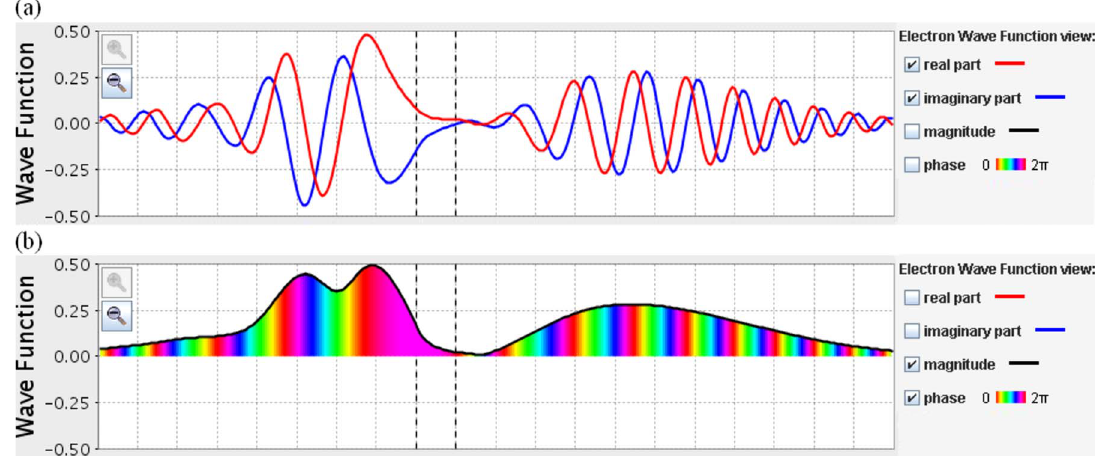
FIG. 13. (cid:1) Color (cid:2) (cid:1) a (cid:2) A representation showing the real and imaginary parts of a wave function and (cid:1) b (cid:2) a representation showing the magnitude and phase of a wave function. In interviews we see that students can make sense of representation (cid:1) a (cid:2) but not representation (cid:1) b